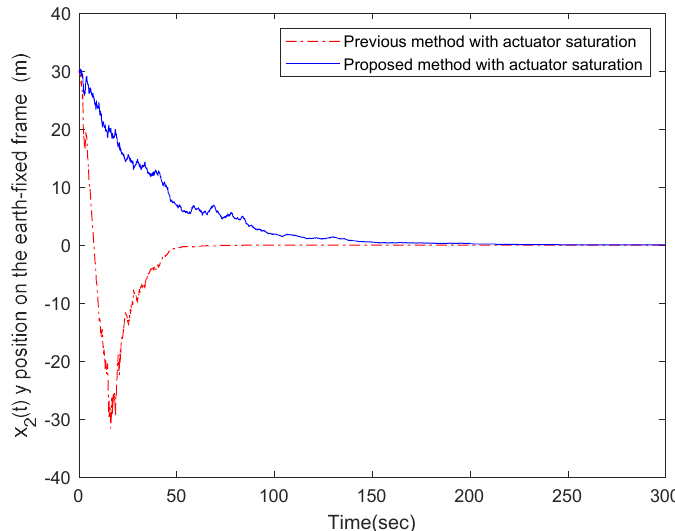
Figure 5. The responses of x ( t ) compared with [29].